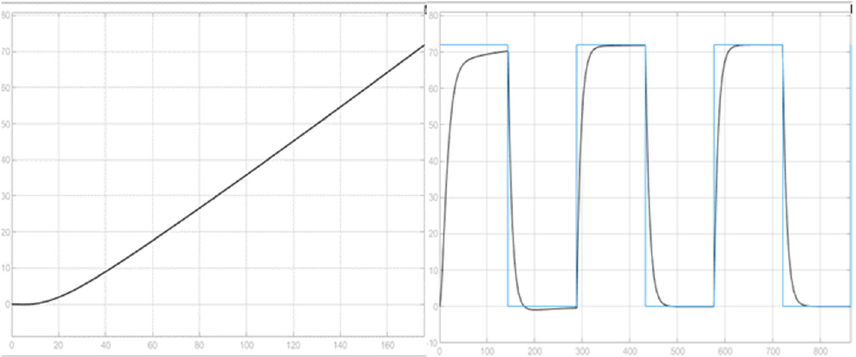
Figure 18. Response of the plate process to a ramp and pulse generator input by cycles, n = 3.